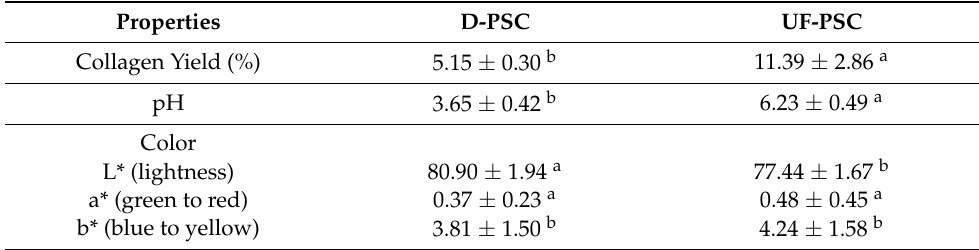
Table 1. Yield, pH and color of D-PSC and